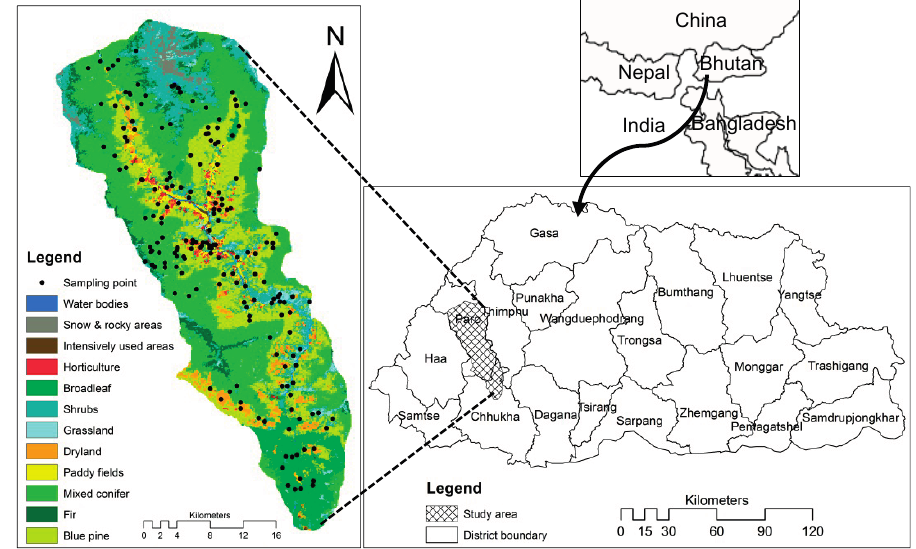
Figure 1. Location of the study area in western Bhutan depicting sampling